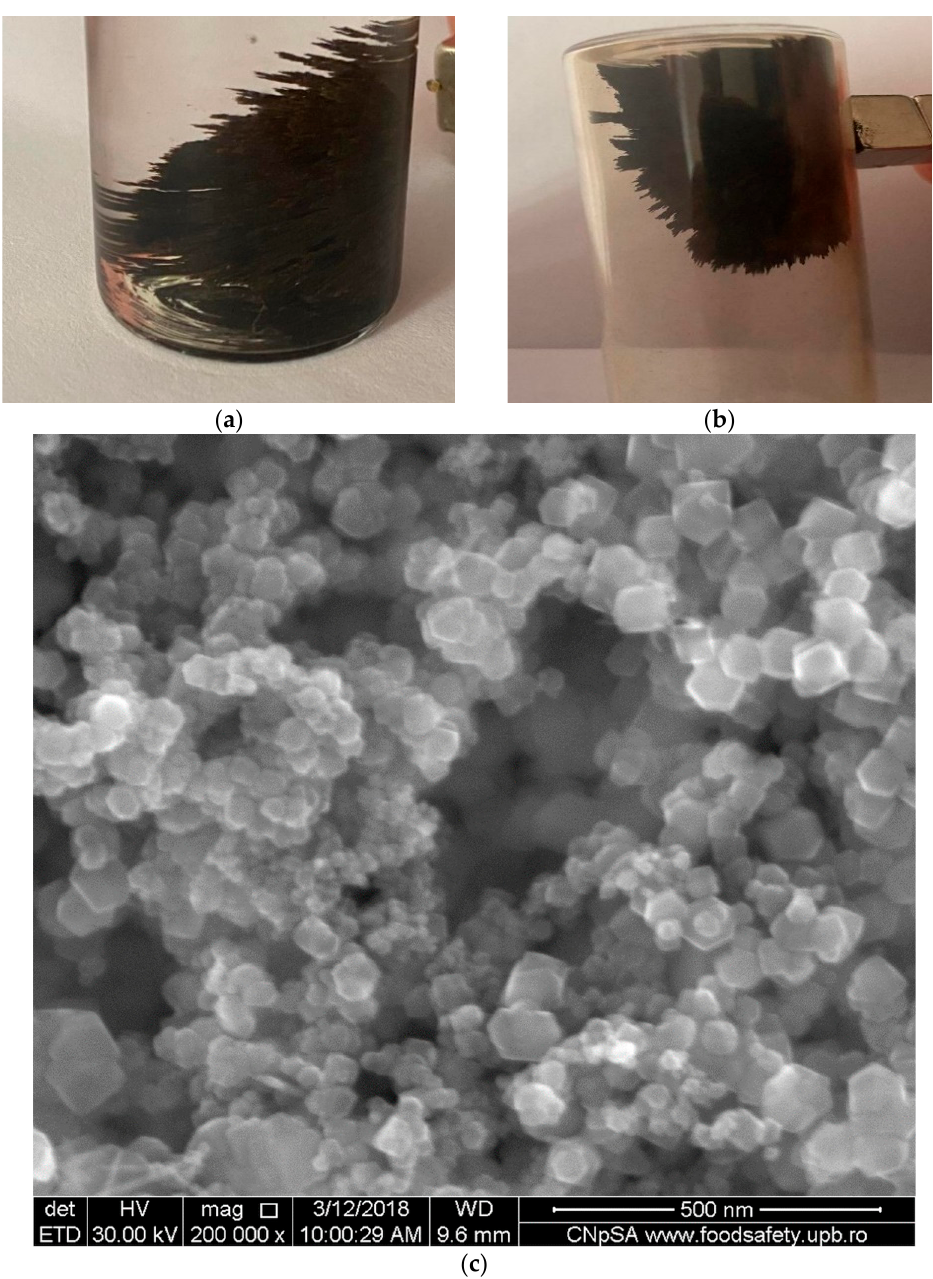
Figure 10. The unitary behavior of the silver–iron oxide membrane material: ( a ) at separation from aqueous solution; ( b ) in the dry state (in the air); ( c ) SEM detail presentation.